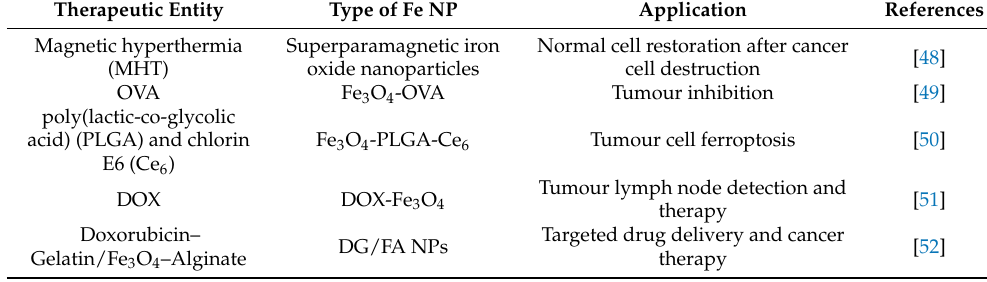
Table 5. Types of FeNPs and their applications in cancer therapy.